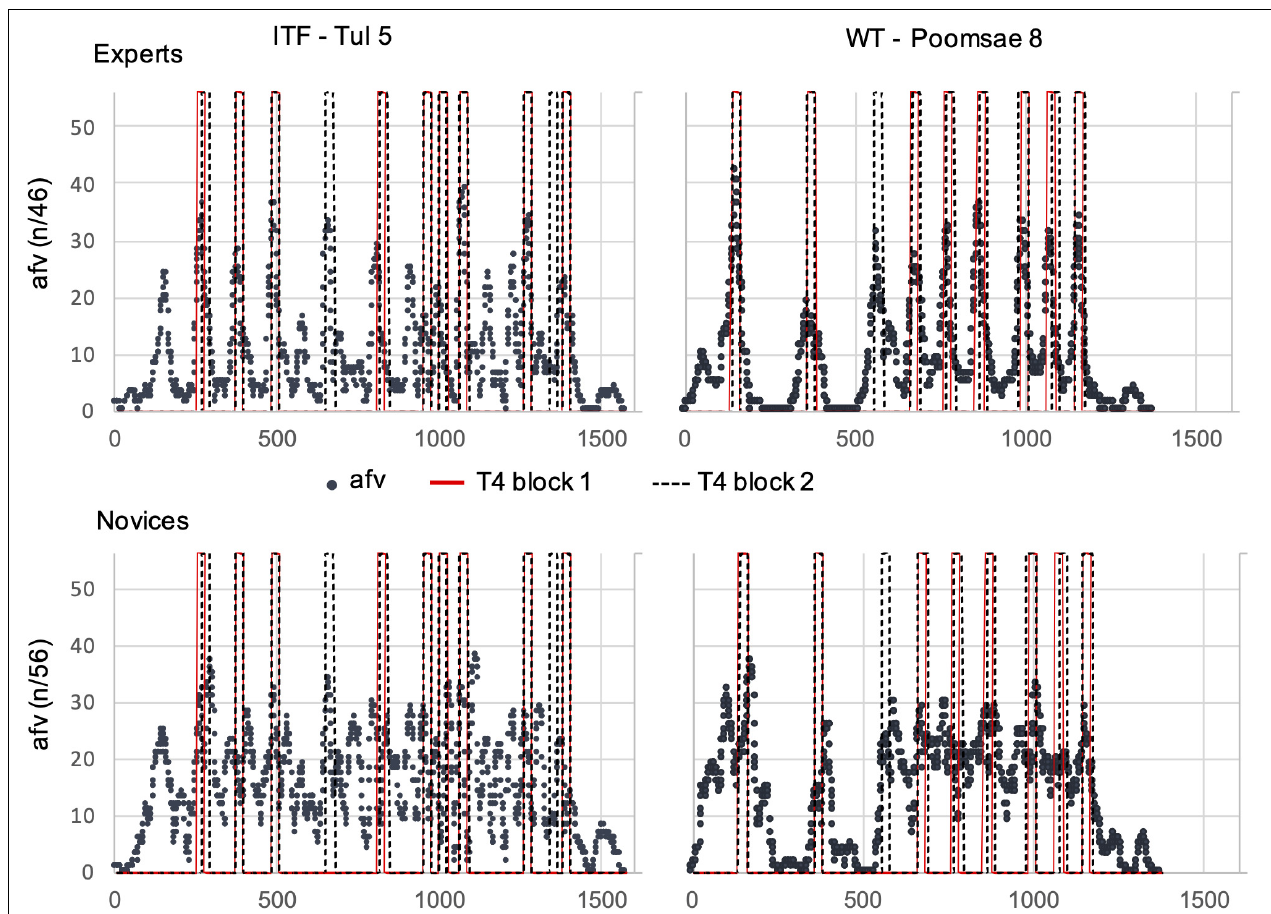
FIGURE 5 | Agreement of within-group responses with boundaries marked by an experienced referee (T4). The added frame values (afv) represent the number of participants responding within each bin (i.e., 1 s prior to each video-frame). Responses of the two blocks are summarized, thus the maximal afv achievable is double the participants in each group (expert group without T4). Red lines represent the boundaries of T4 in block 1, dashed black lines are boundaries from block 2. The exact times of the responses of T4 are at the line marking the end of the 1 s bin during which they are counted (see computation of afv). Two actions, TUL #5 and Poomsae #8, are shown. The complete set of figures for all videos and both groups is provided in Supplementary Figure 1 . In addition, the two videos with concurrent afv of both groups are provided as Supplementary Material